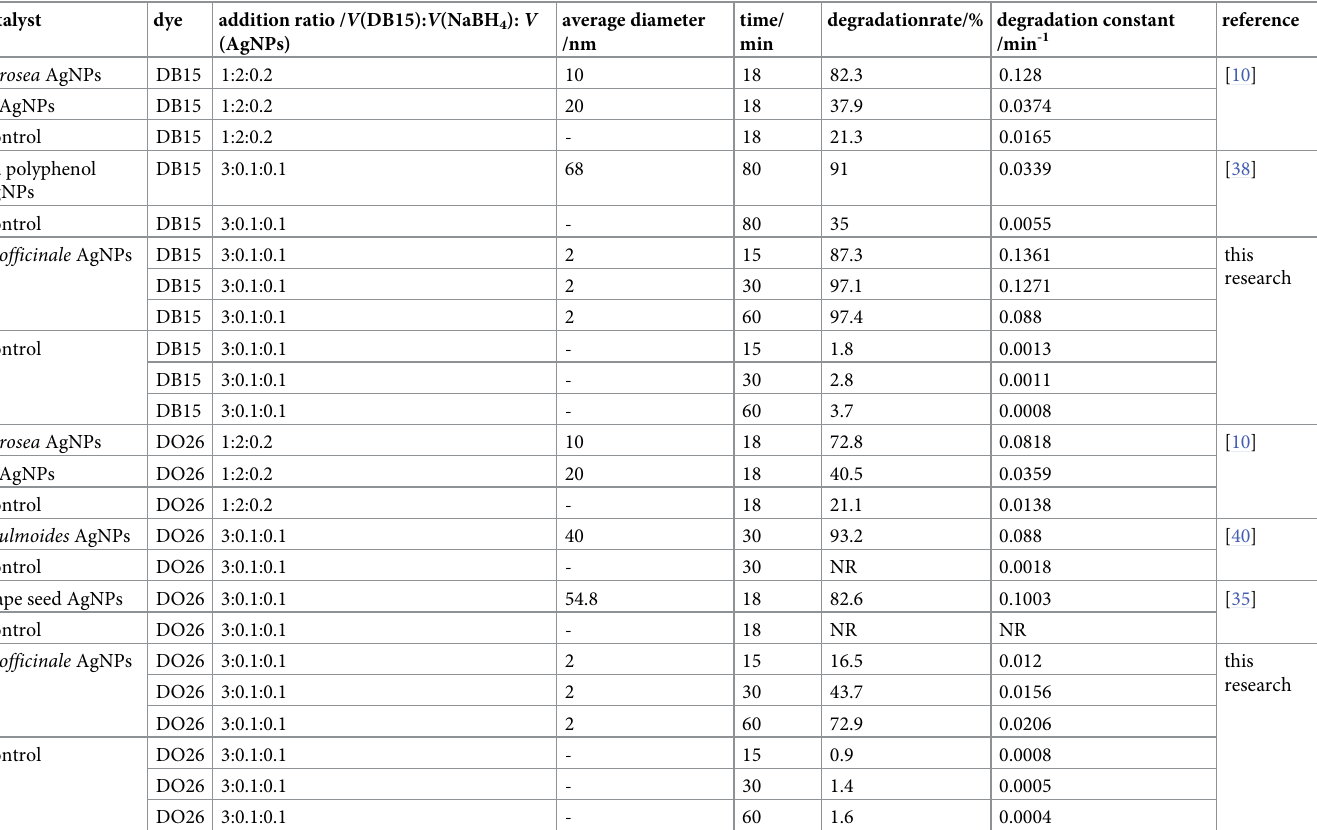
Table 5. Comparisons of degradation parameters for DB15/DO26 by AgNPs synthesized from different plant extracts between reported references. catalyst dye addition ratio / V (DB15): V (NaBH 4 ): V (AgNPs)